Question: In one sentence, what is this figure communicating?
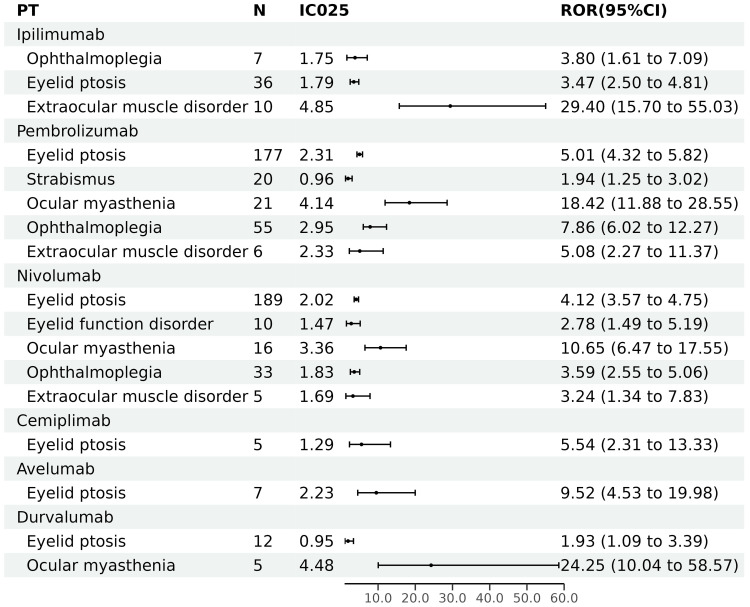
Answer: Results of correlation analysis of neuro-ophthalmic irAEs at the PT level.